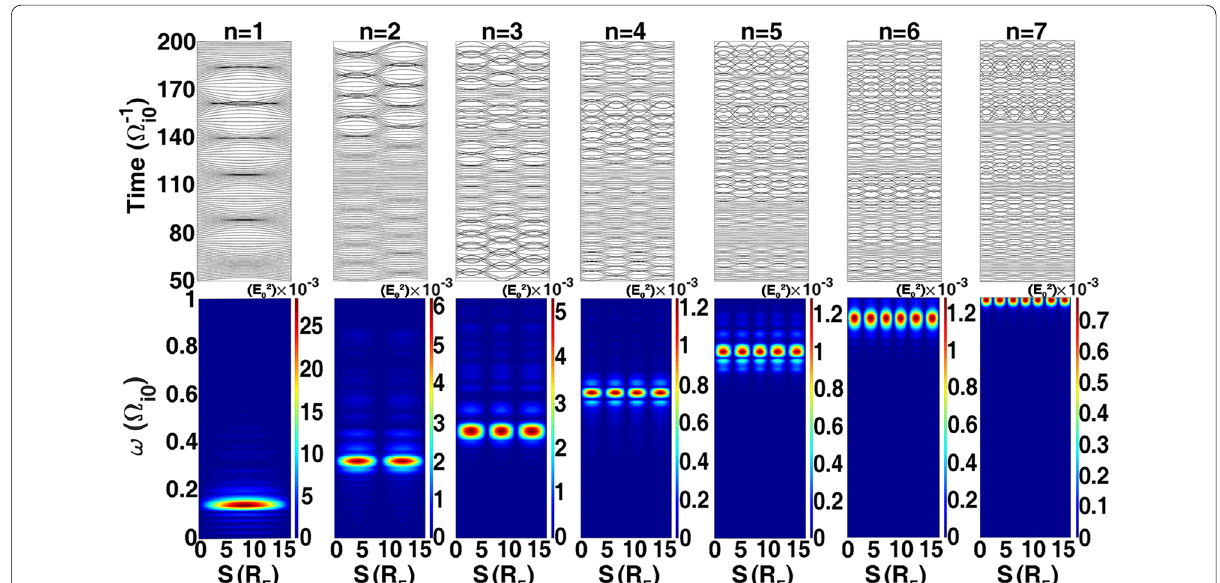
8 R E . Top panel: the first 7 harmonic =